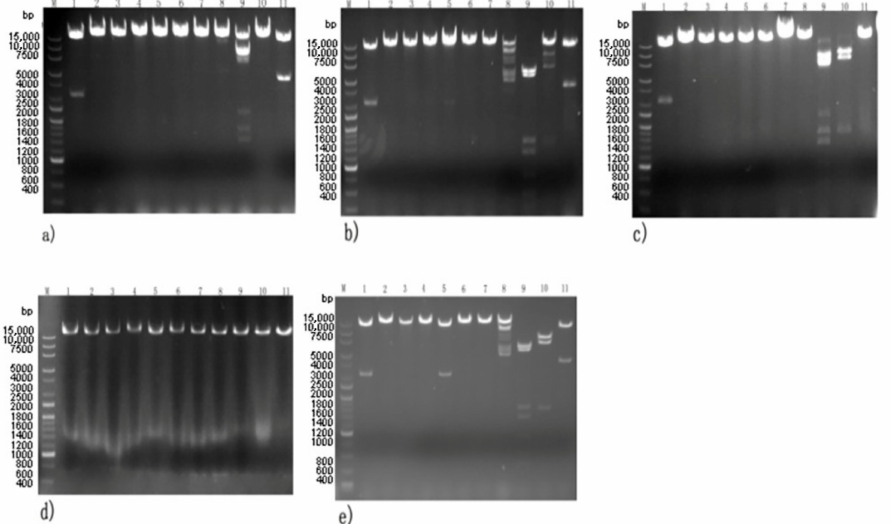
Figure 5. Agarose gel electrophoresis of generated DNA fragments of the isolated phages by digestion with 11 restriction enzymes. Lane M, DL 15,000 marker. Restriction endonuclease digestion map of phage 4086-1 ( a ), phage 4086-2 ( b ), phage 4086-3 ( c ), phage 4086-4 ( d ), phage 4086-6 ( e ) digested by restriction enzymes EcoR I (1), Hpa I (2), Rsr II (3), Sac I (4), Sph I (5), Bgl II (6), Sma I (7), Sac II (8), SnaB I (9), Avr II (10), and Pst I (11), respectively.